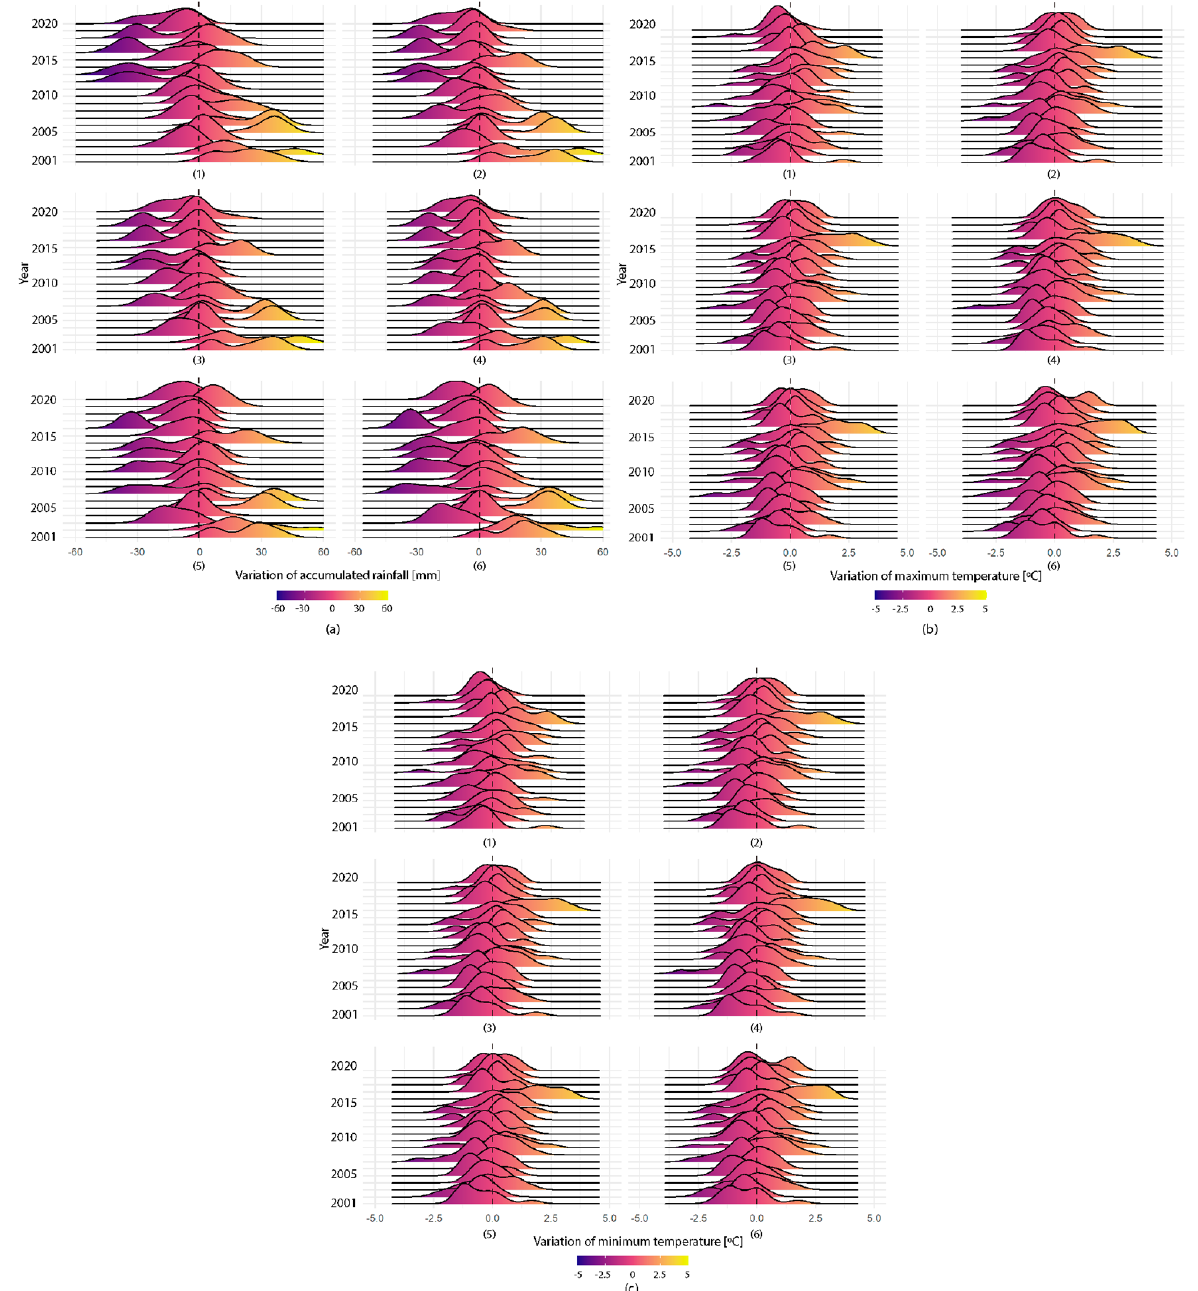
Figure 2. Variation density distribution graph of ( a ) accumulated rainfall, ( b ) maximum and ( c ) minimum temperature in Biobio from 2001 to 2020 for the agro-climatics areas: ( 1 ) Secano Costero, ( 2 ) Secano interior, ( 3 ) Depresión Intermedia, ( 4 ) Cordón Isla, ( 5 ) Precordillera and, ( 6 ) Cordillera. The time series of accumulated rainfall, maximum temperature and minimum tem-